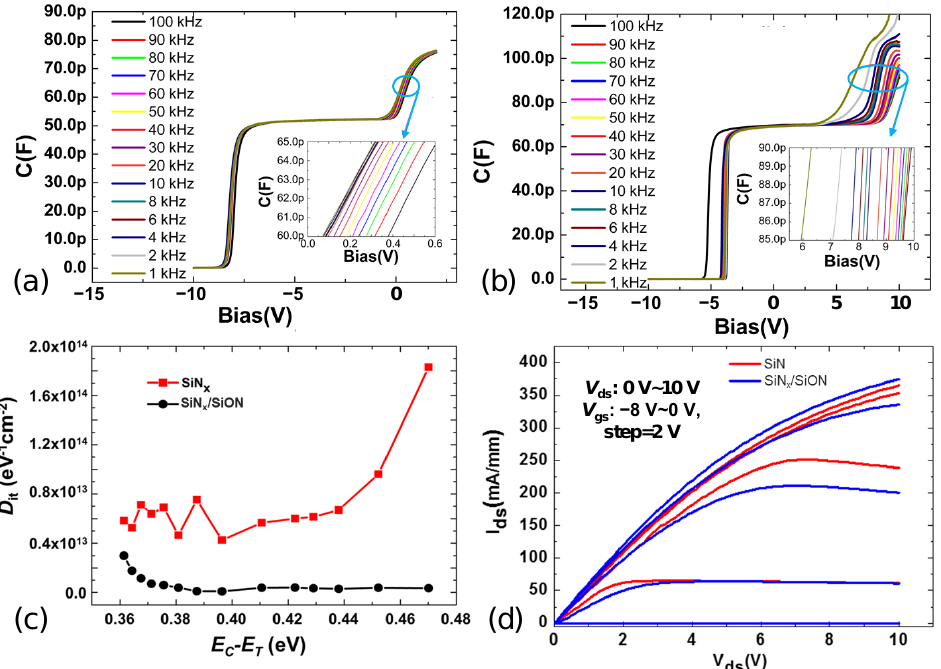
Figure 5. C-V curves of AlGaN/GaN MISHEMTs with ( a ) Si 3 N 4 /SiON composite gate dielectrics and ( b ) SiN x gate dielectric. ( c ) The interface state density as a function of energy level for the AlGaN/GaN MIS-HEMTs with different gate dielectrics. ( d ) Output curves of the two kinds of devices.